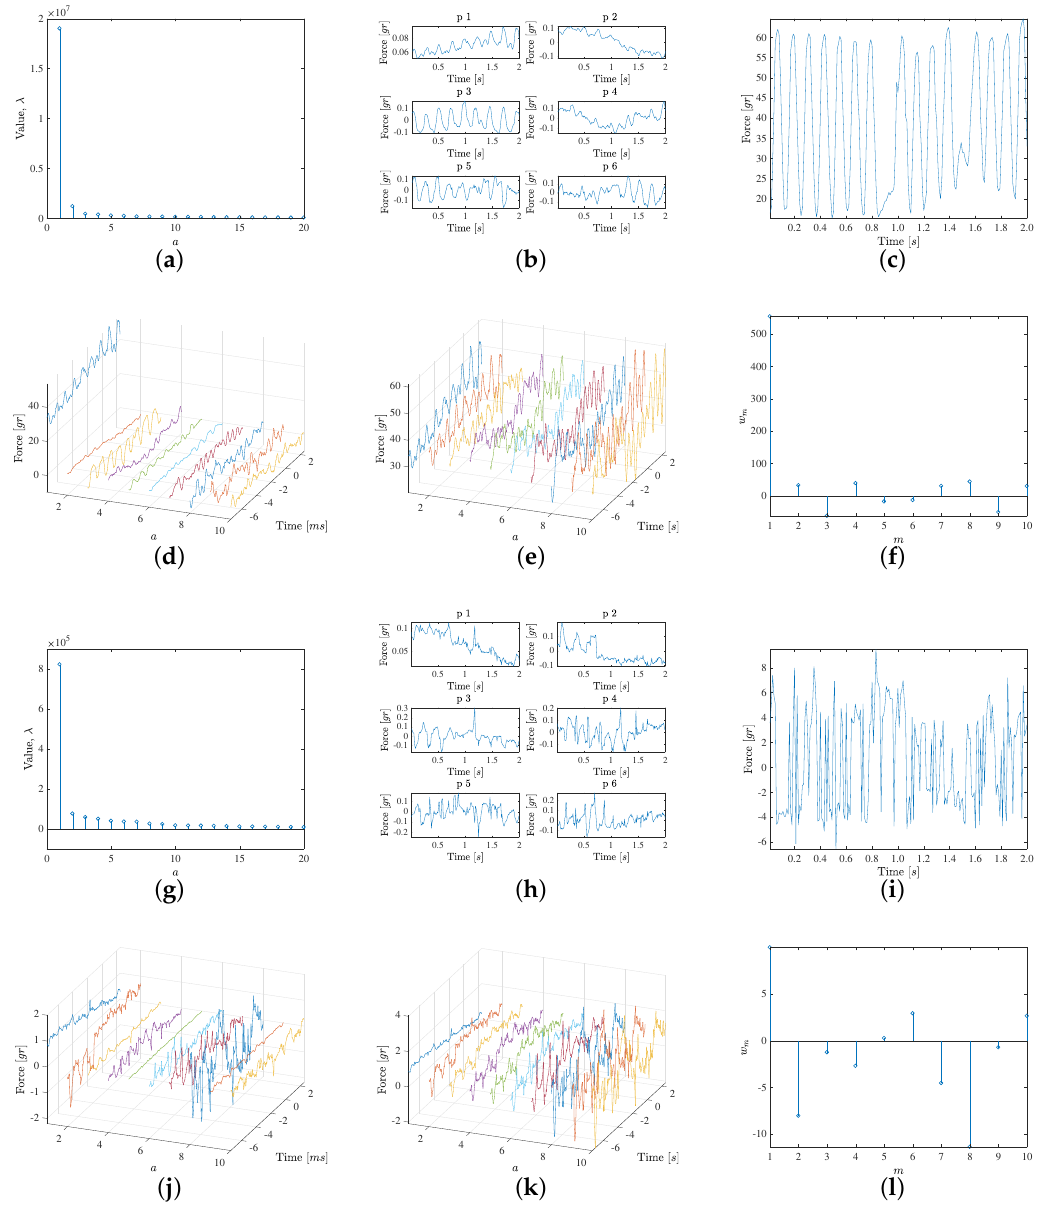
Figure 3. PCA results for the high-confidence contact ( a – f ) and non-contact ( g – l ) groups, separately: ( a , g ) First 20 eigenvalues; ( b , h ) Signal patterns for the first six eigenvectors of the decomposition; ( c , i ) Examples of signals with clearly stable and loose contact; ( d , j ) Contributions of the first 10 eigendirections weighted by the example signal projection on them; ( e , k ) The same for the accumulated contributions; ( f , l ) Weights of the projected example signal on those first 10